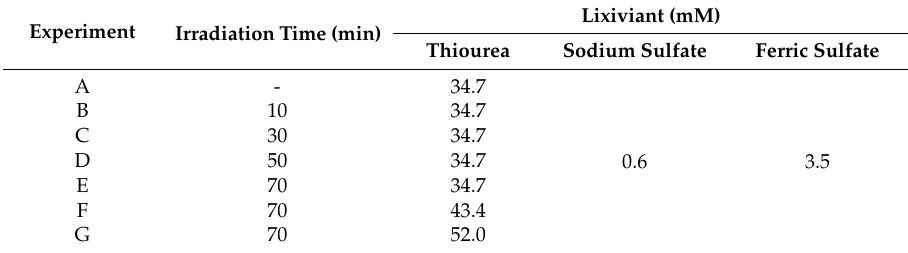
Table 1. Experimental conditions of microwave pretreatment and thiourea leaching.